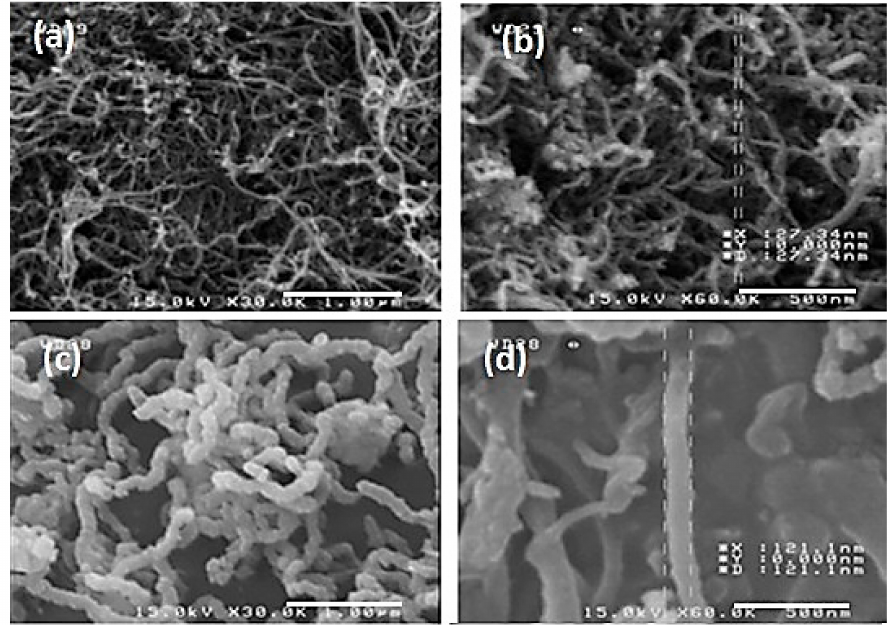
Figure 4. SEM image of pristine CNTs ( a , b ) using ultrasonic bath (the scale bars represent 1 µ m and 500 nm, respectively) and ( c , d ) using stirring heater (the scale bars represent 1 µ m and 500 nm, respectively) (catalyst concentration = 4 wt %, hydrogen flow = 200 cm 3 /min, and temperature = 1000 ◦ C). Table 3. Experimental runs based on central composite design (CCD) and Raman spectroscopy data at constant reaction time (80 min) and internal diameter (2.5 cm). Run